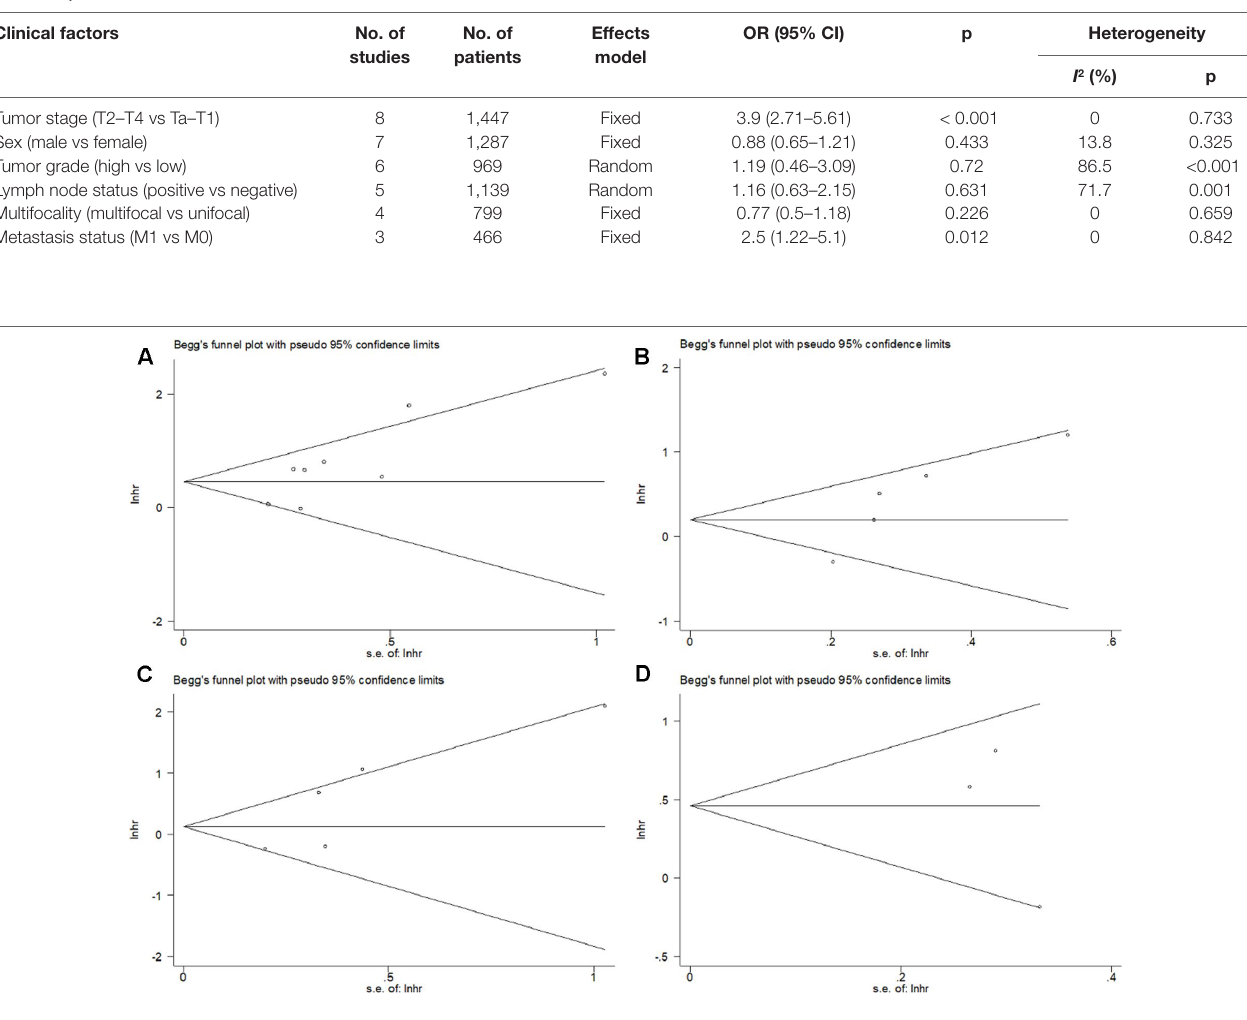
FIGURE 3 | Begg’s funnel plot for publication bias test including PD-L1 expression and (A) OS, (B) RFS, (C) CSS, and (D) DFS in bladder cancer